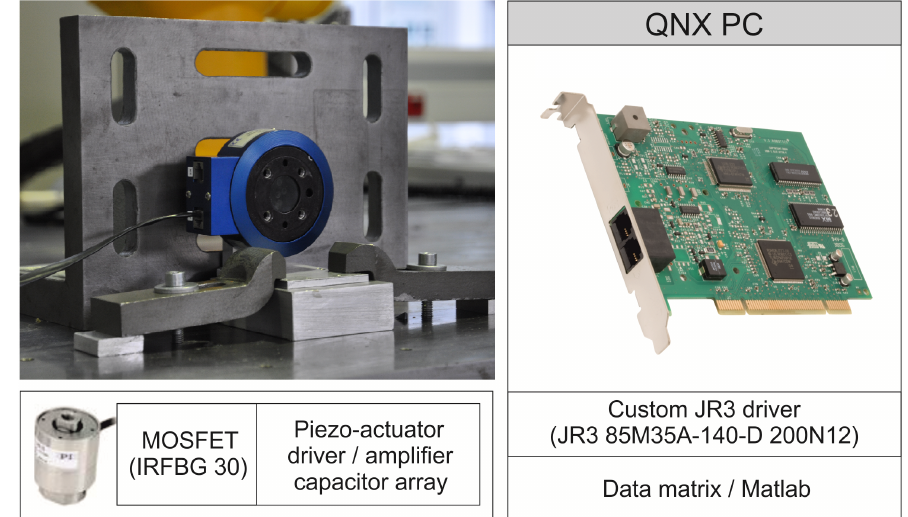
Figure 2. The structure of the experimental setup. The JR3 sensor is fitted with a rubber-coated steel disc at the center and attached to a rigid steel